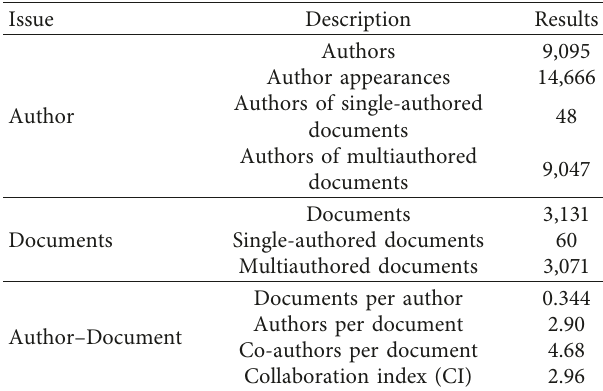
Table 5: Analysis of co-authorship from 2000 to 2020.